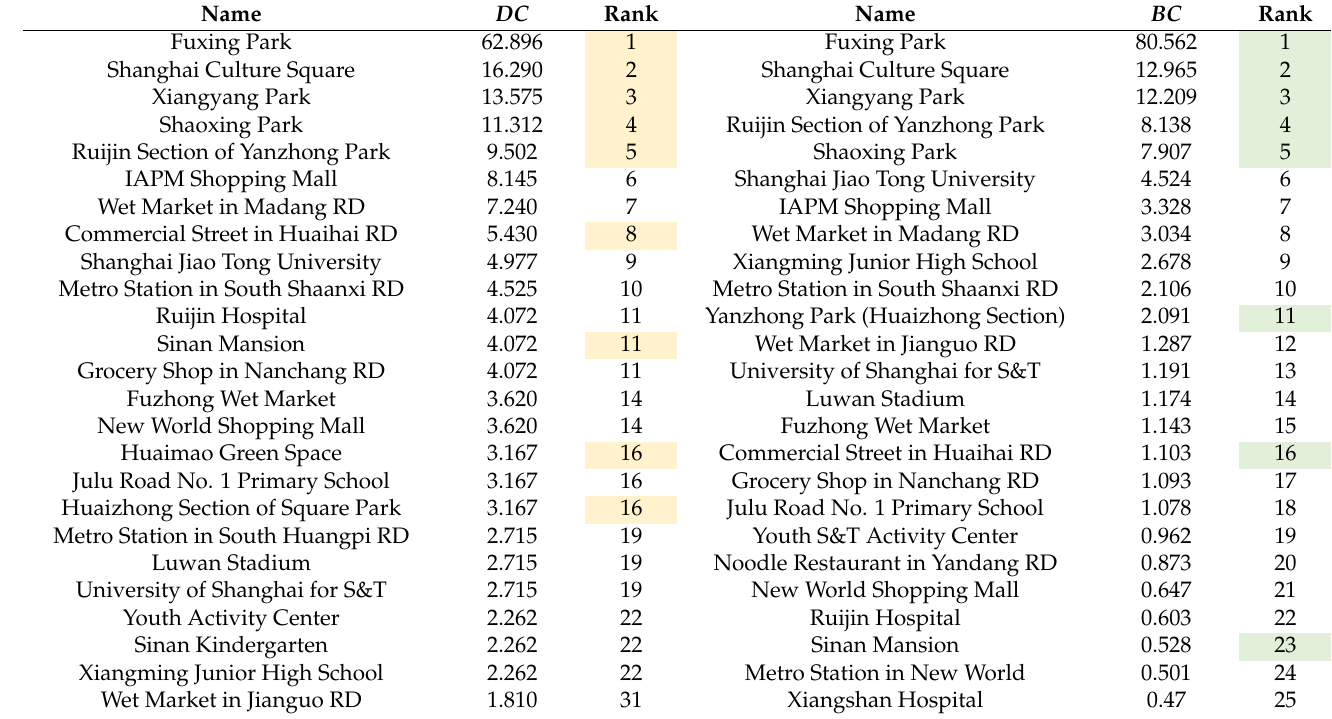
Figure 6. DC of nodes: ( a ) DC in the spatial network; ( b ) DC in the behaviour network. Table 4. Centralities of nodes in network matrix